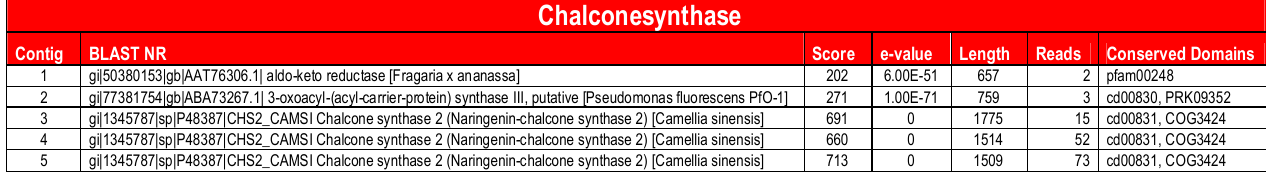
Table S11: EST-Contigs with e-value < e -20 and score > 100 obtained in the Project Chalconesynthase, and their blast hit, score, e-value, size, number of reads, and conserved domains from putative